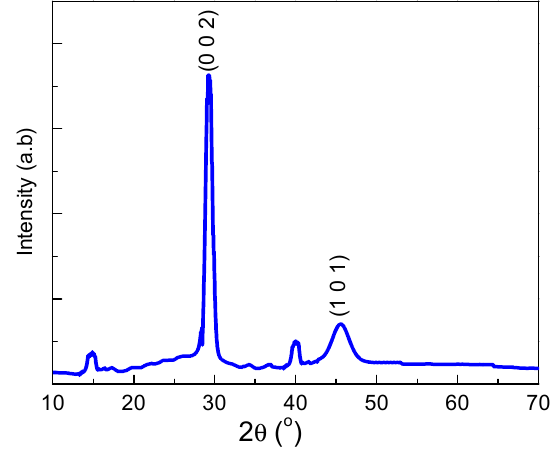
Figure 3. XRD pattern of the PGC-60 film.